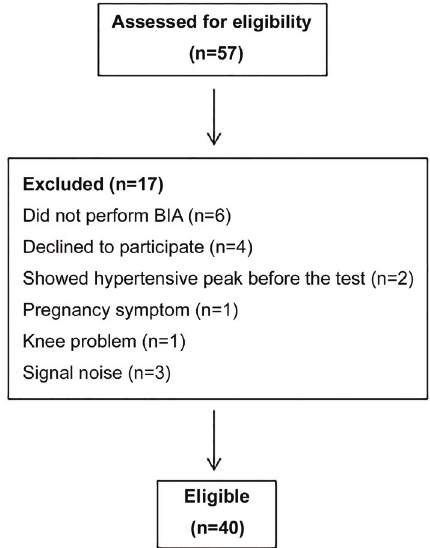
Figure 1. Flowchart of the subjects. BIA: bioelectrical impedance analysis.